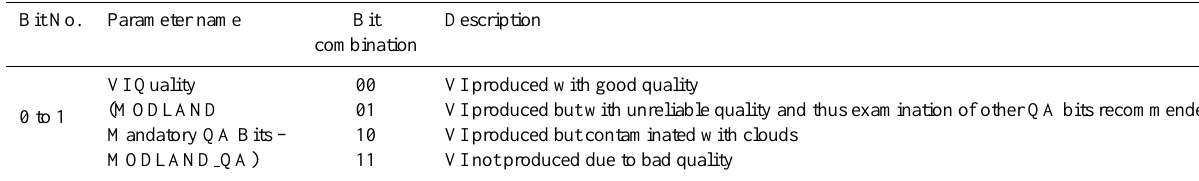
Table 1. Descriptions of the Vegetation Index (VI) Quality Assessment (QA) Science Data Sets (adopted from MOD13 User Guide). Bit No.